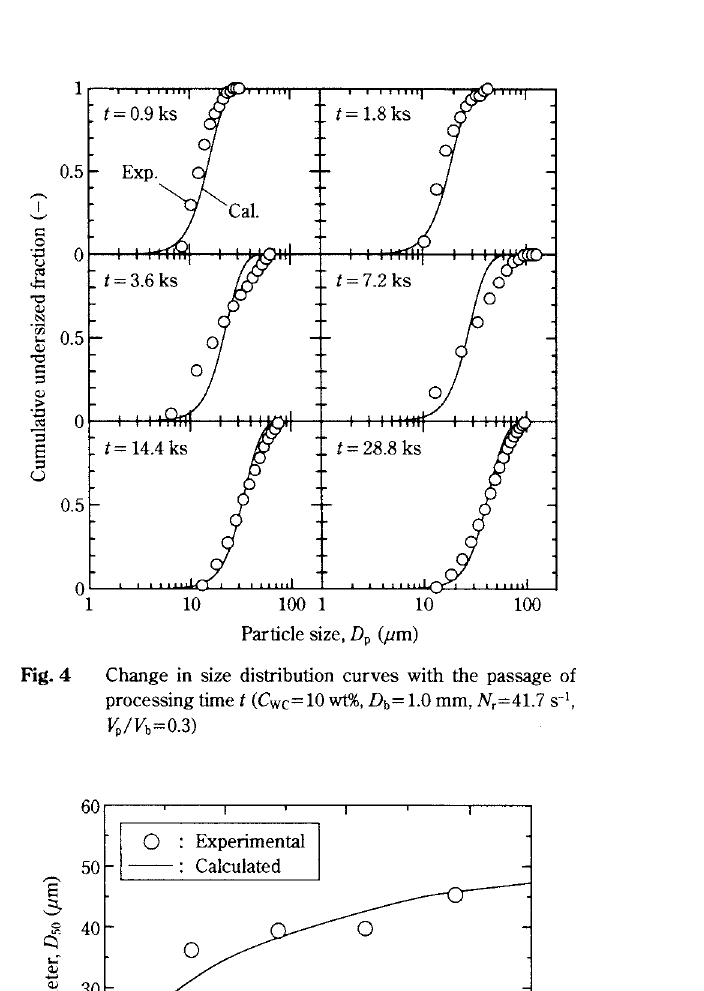
Fig. 5 Change in D 50 with the passage of processing time